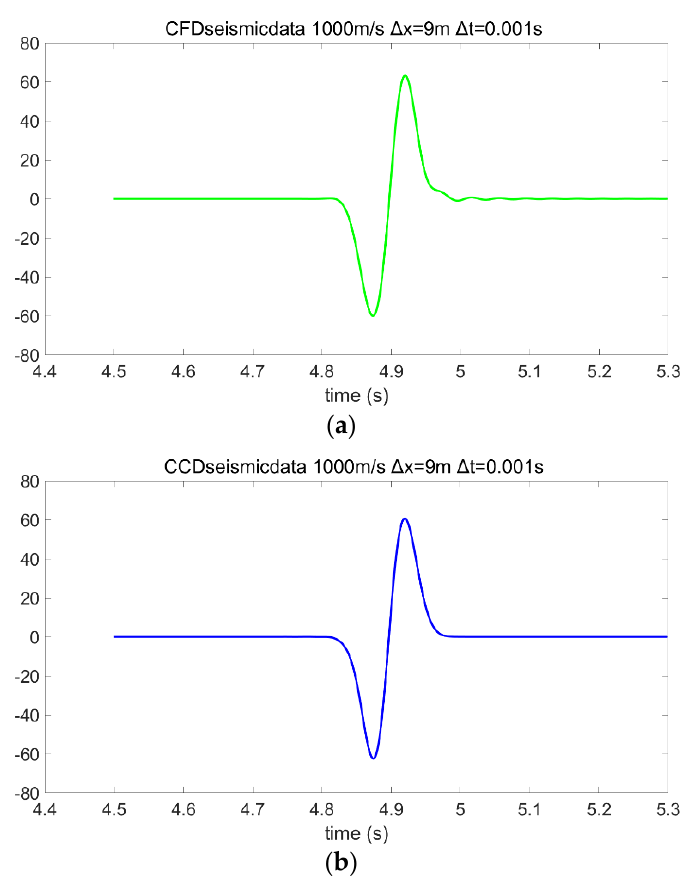
Figure 3. ( a ) CFD is used to simulate the numerical simulation of seismic records in the 1D homogeneous medium model, Δ x = 9 m; ( b ) CCD is used to simulate the numerical simulation of seismic records in the 1D homogeneous medium model, Δ x = 9 m.